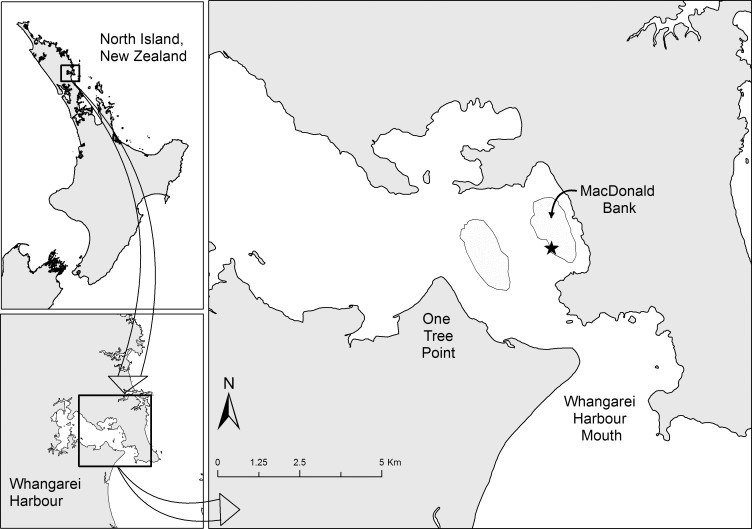
Map of Whangarei Harbour.Intertidal sand banks indicated by light grey shading and the location of the Artificial Seagrass Unit array denoted by a black star. North Island, New Zealand and Whangarei Harbour inset.